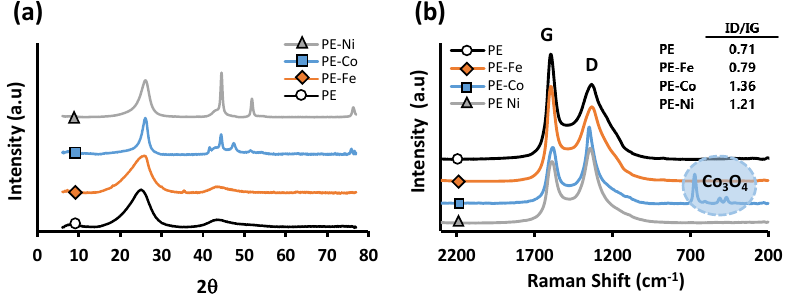
Figure 5. ( a ) XRD patterns ( b ) and Raman spectra.